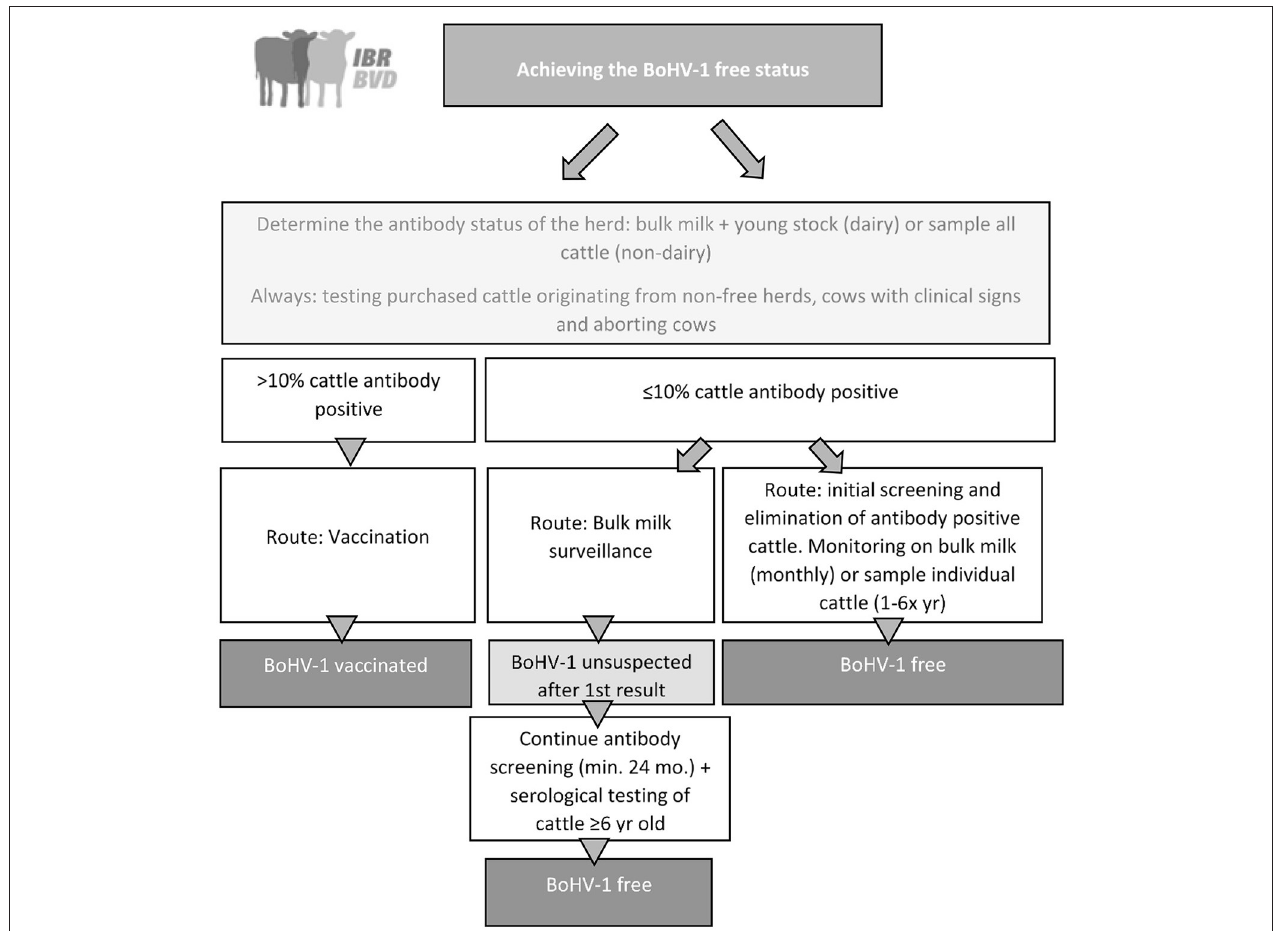
FIGURE 2 | Graphical overview of the national BoHV-1 control program in the Netherlands that was implemented in